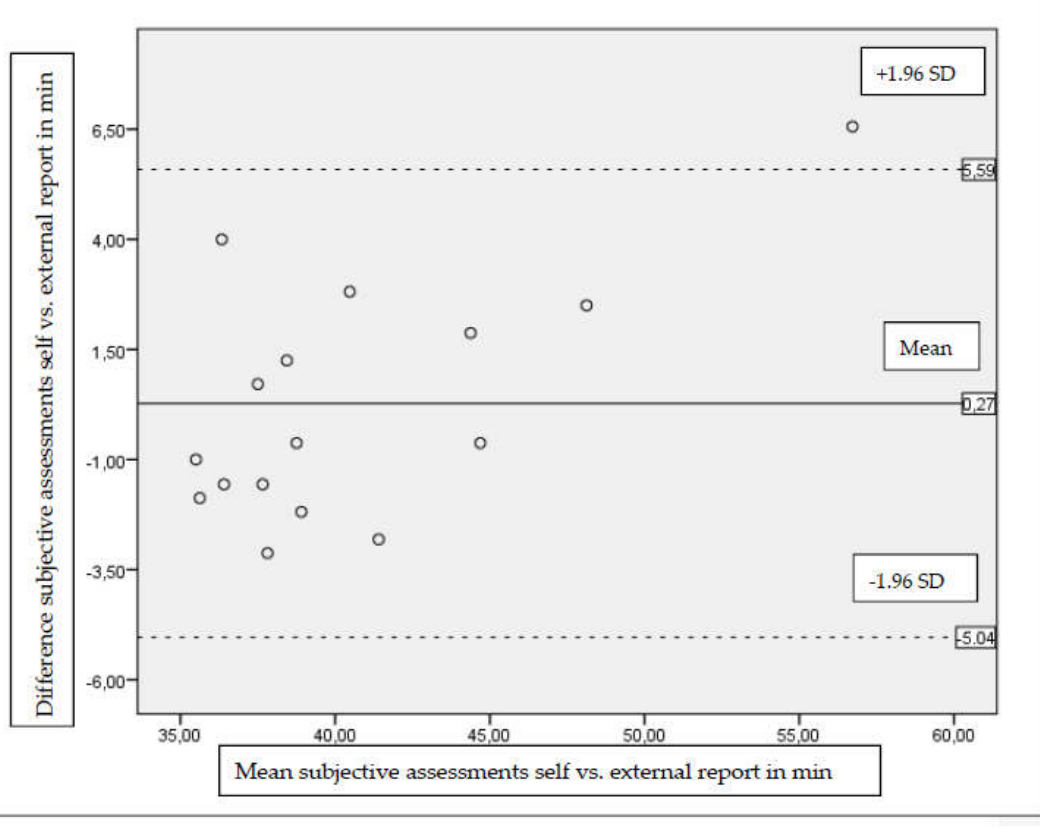
Figure 2. Comparison between the two subjective measures (self vs. external report) of standing time using Bland-Altman plots. The chart presents the mean difference (intermediate line) and ±1.96* standard deviation of difference (upper and lower line), showing the limits of agreement.